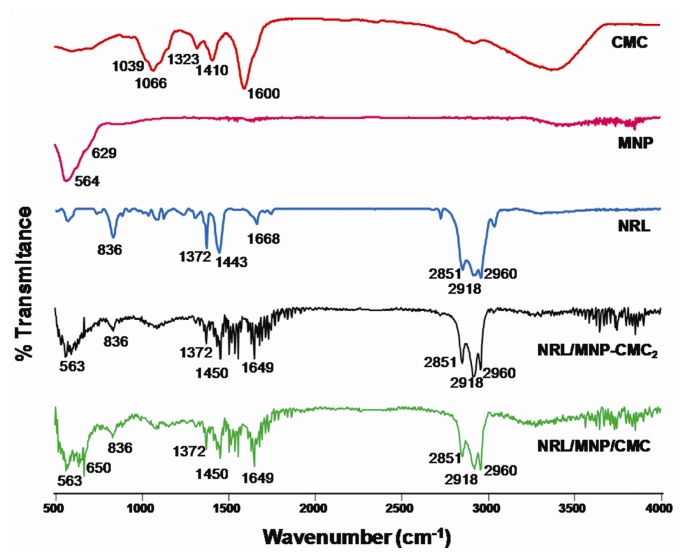
FTIR spectra for NRL/MNP/CMC and NRL/NMP-CMC2 LbL films and cast films of CMC, MNP and NRL. The MNP band at 563 cm−1 appears for both LbL films, while the band at 629 cm−1 for the cast film appears in the trilayer LbL film at 650 cm−1. This band is not evident in the LbL film because each bilayer was obtained with a mixed MNP and CMC solution, sonicated 30 min before using, and under such conditions CMC might form a structure surrounding the MNP, thus causing changes in the vibrational spectrum. In other words, the shift is probably due to steric hindrance, being typical in LbL films owing to the intimate contact between the film components [55].